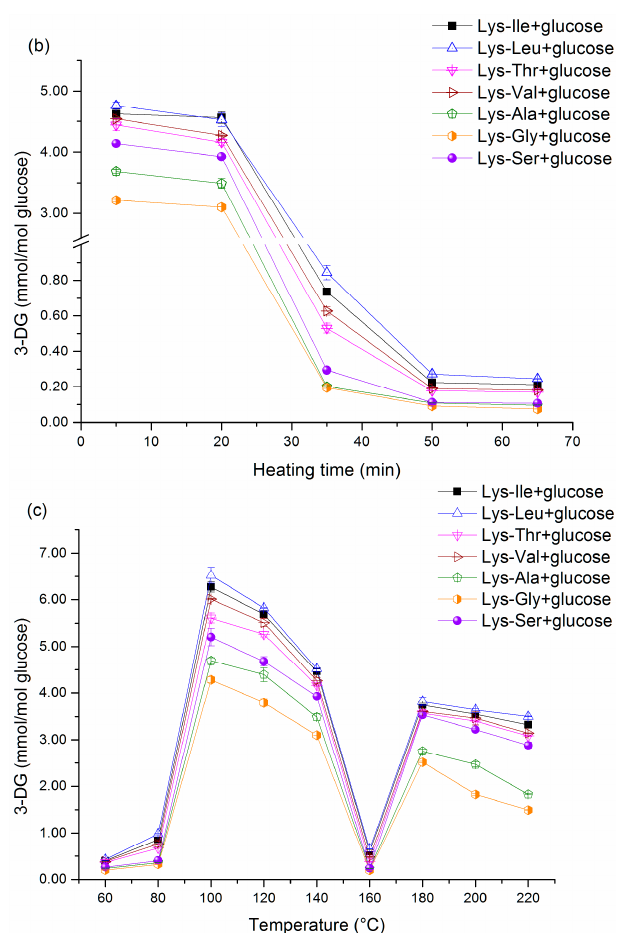
Figure 1. 3-DG content in the heat-treated dipeptide-glucose mixtures, ( a ) dipeptide-glucose mixtures at different initial molar ratios, time 20 min, temperature 140 °C; ( b ) dipeptide-glucose mixtures at various heat-treated times, initial molar ratio 1:1, temperature 140 °C; ( c ) dipeptide-glucose mixtures at different heating temperatures, initial molar ratio 1:1, time 20 min.